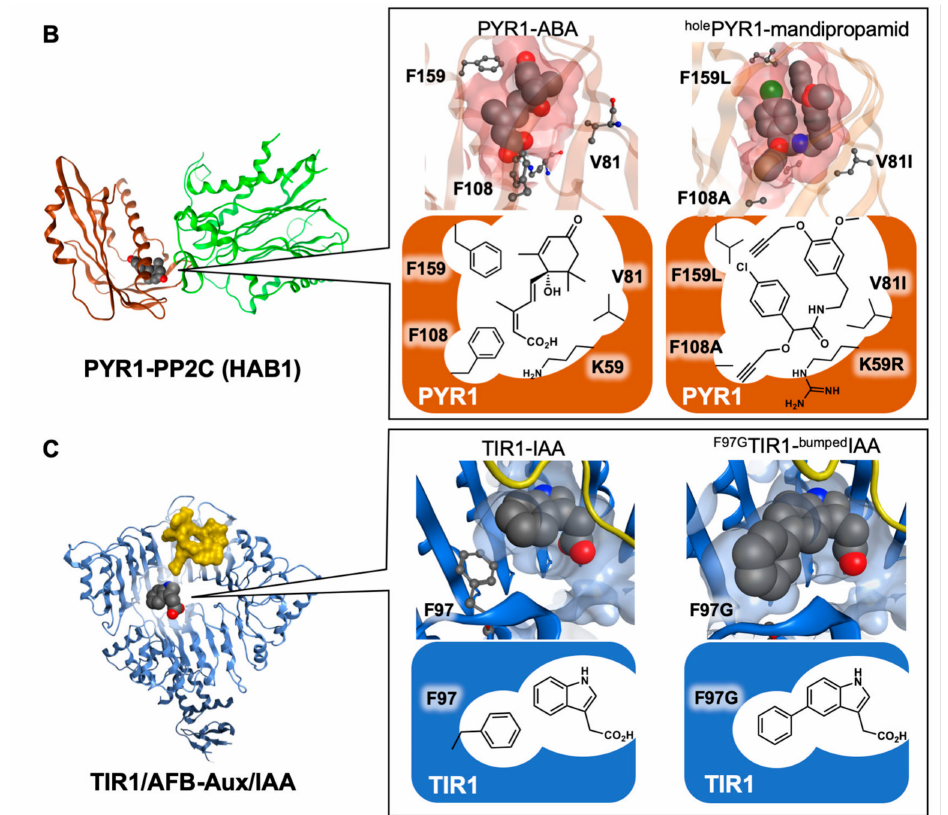
Figure 4. Protein engineering on ligand-receptor interaction. ( A ) Comparison of the A384V COI1 (green) / COR / JAZ1 (orange) complex ( left ) and the A384V COI1 / JA-Ile complex ( right ) at the ligand binding pocket; ( B ) comparison of the PYR1 (brown) / ABA / HAB1 (green) complex ( left ) and the holed PYR1 / mandipropamid complex ( right ) at the ligand binding pocket; ( C ) comparison of the TIR1-AFB (blue) / IAA / Aux-IAA (yellow) complex ( left ) and the holed TIR1 / bumped IAA complex ( right ) at the ligand binding pocket. The structures and surfaces were modeled, docked, and rendered using MOE from ( A ) 3OGM, 3OGL; ( B ) 3QN1, 4WGD; and ( C ) 2P1Q, respectively. The ligand molecules are highlighted in sphere, and mutated residues are highlighted in either sphere or ball-and-stick, Red ball is oxygen and blue ball is